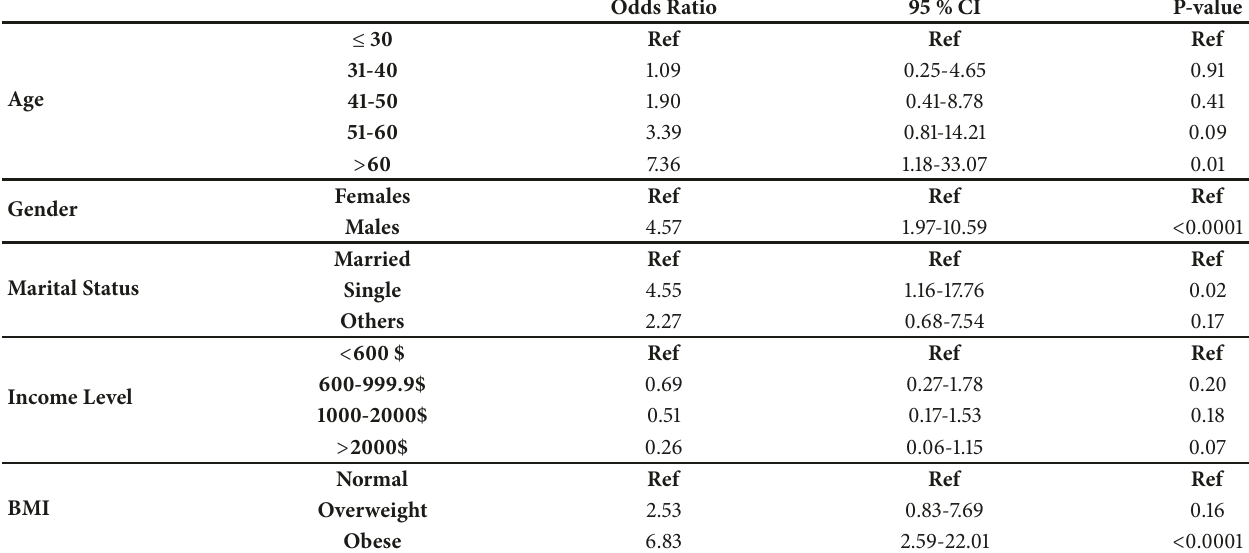
Table 5: Multiple logistic regression model for the unaware hypertensive versus the normotensive